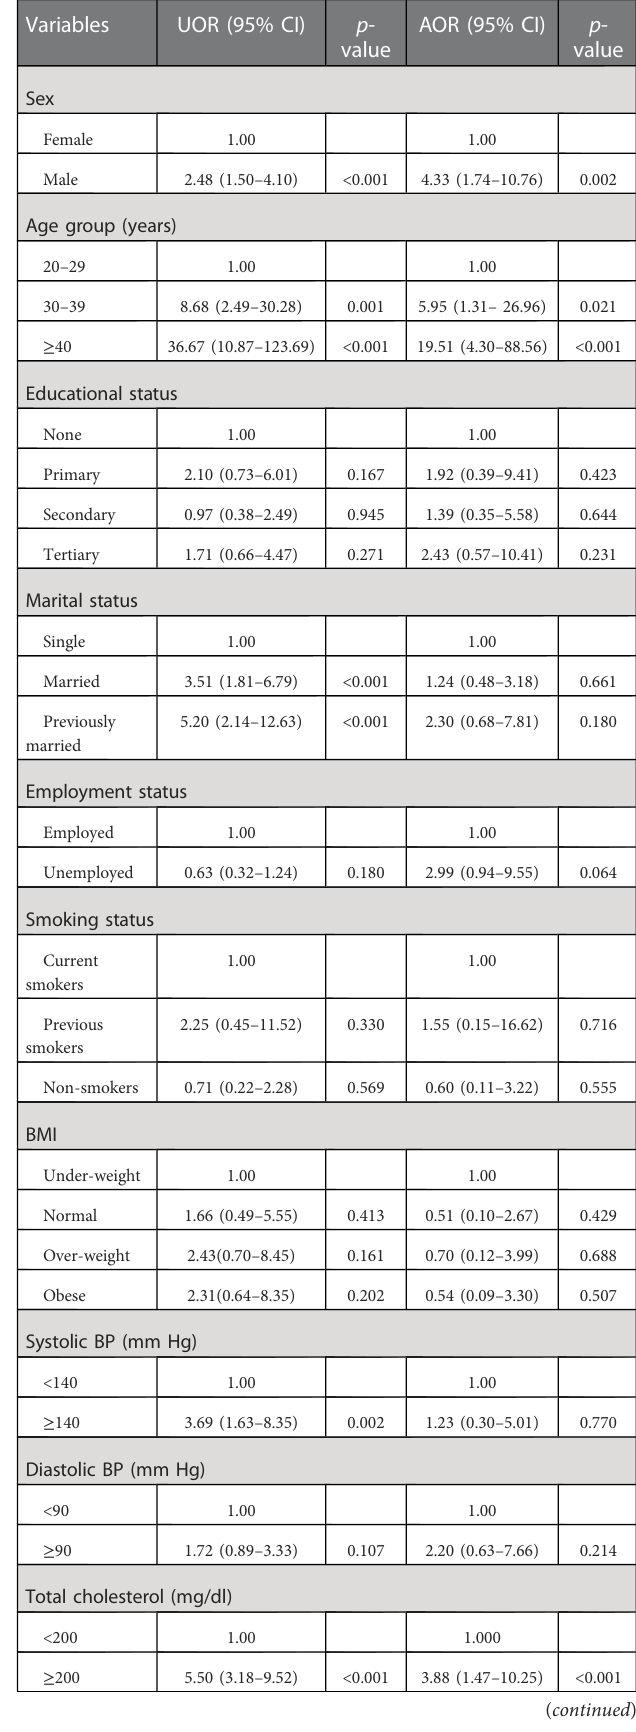
TABLE 4 Crude and adjusted associations of subclinical atherosclerosis and socio-demographics, clinical parameters, and HIV-related characteristics (model